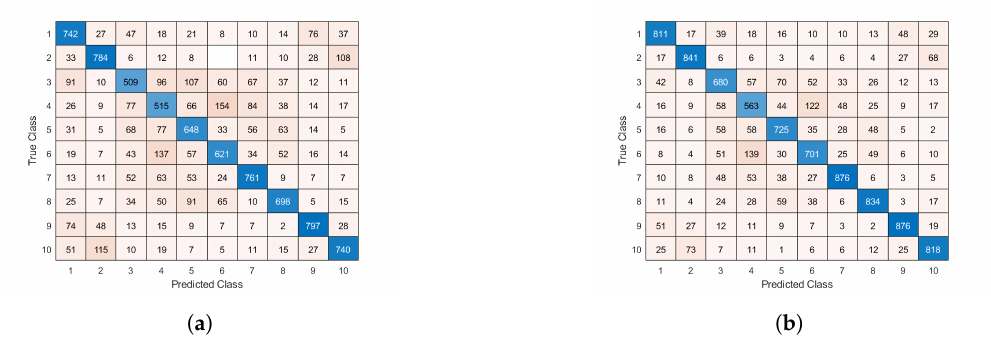
Figure 17. Confusion matrix of ( a ) the vanilla CIFAR-10 network topology and ( b ) the adaptive CIFAR-10 network topology.